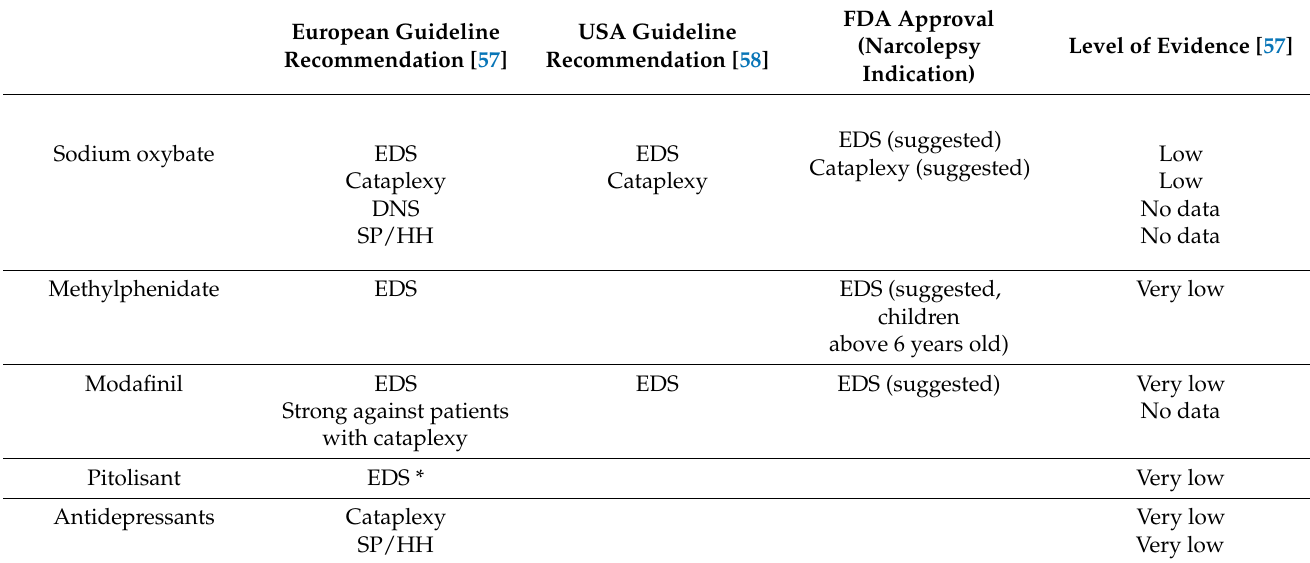
Table 1. Overview of medications available in pediatric